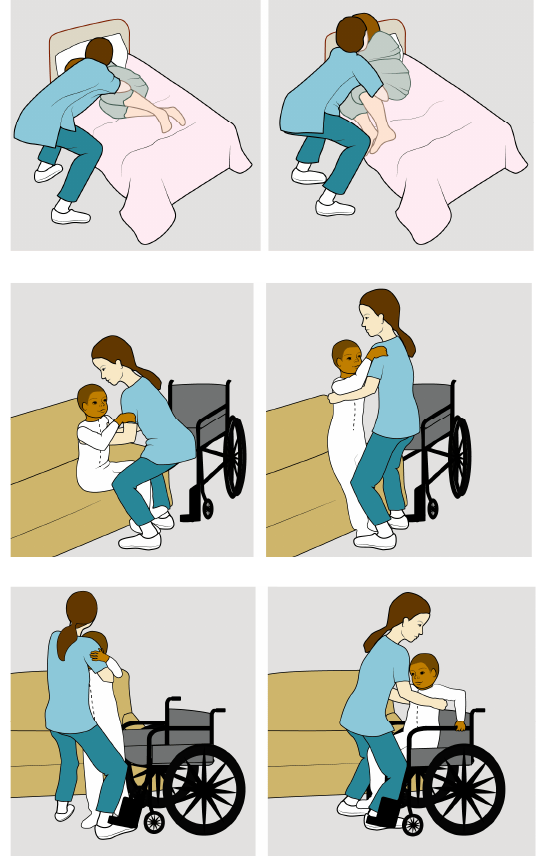
Figure 1. Assisting standing up in a bed, standing up from and sitting down in a wheel chair, requiring the career to bend at a distance [39]. Reproduced with permission from OrthoInfo. © American Academy of Orthopaedic Surgeons. https://orthoinfo.org/.